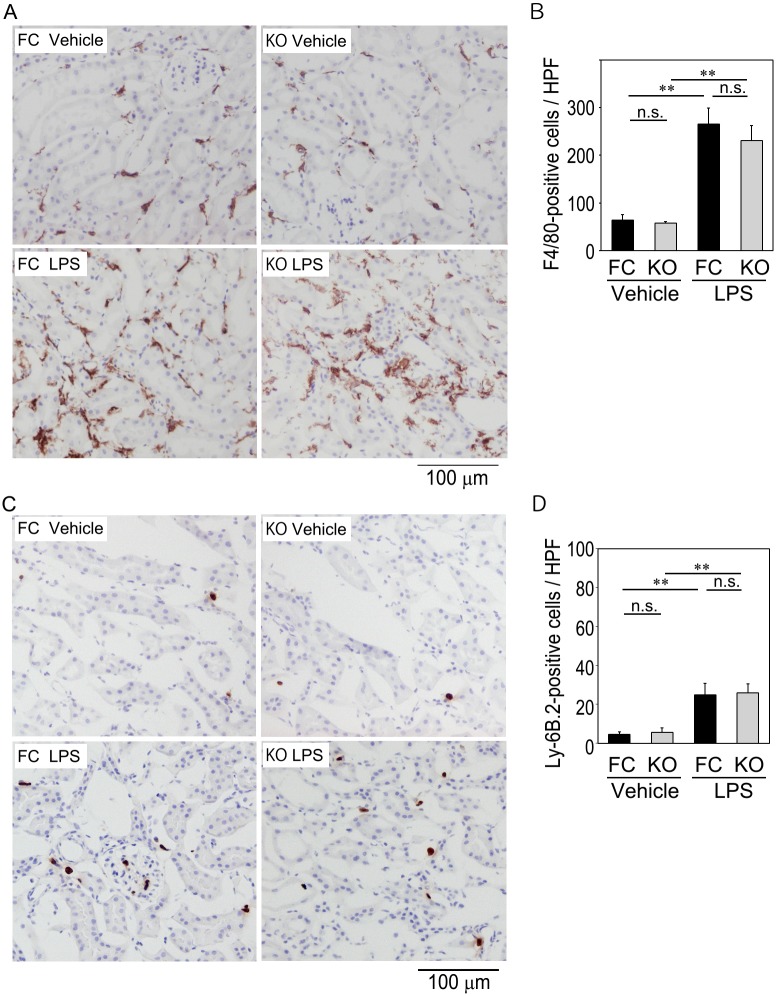
Immunostainings of macrophages and neutrophils in the kidneys of M-Rac1 FC and KO mice.(A) Representative micrographs of F4/80 immunostaining in the kidneys of Vehicle- or LPS-injected M-Rac1 FC and KO mice. Original magnification x 200. (B) Quantitative analysis of F4/80-positive macrophages. Data are means ± s.e.m. Statistical analysis was performed by two-way ANOVA, n.s. genotype effect, P < 0.01 treatment effect, n.s. interaction effect. **P < 0.01 by Bonferroni's post hoc test. n = 5 per each group. (C) Representative micrographs of Ly-6B.2 (mAb 7/4) immunostaining. (D) Quantitative analysis of Ly-6B.2-positive neutrophils. Statistical analysis was performed by two-way ANOVA, n.s. genotype effect, P < 0.01 treatment effect, n.s. interaction effect. **P < 0.01 by Bonferroni's post hoc test. n = 6 per group.